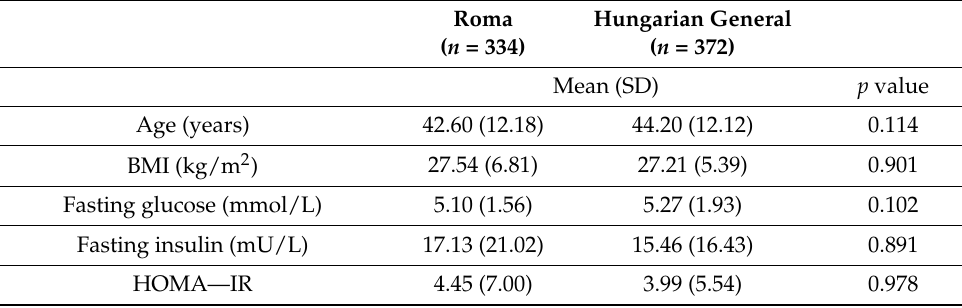
Table 1. Characteristics of the Roma and Hungarian general